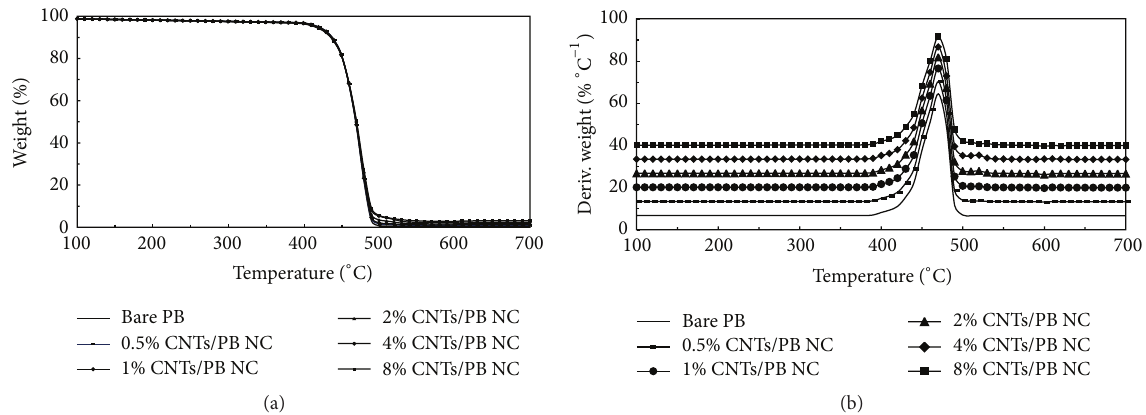
Figure 4: TGA-DTG curves: TGA (a) and DTG (b) of unfilled PB and CNTs/PB nanocomposites containing 0.5, 1, 2, 4, and 8% by weight of CNTs.